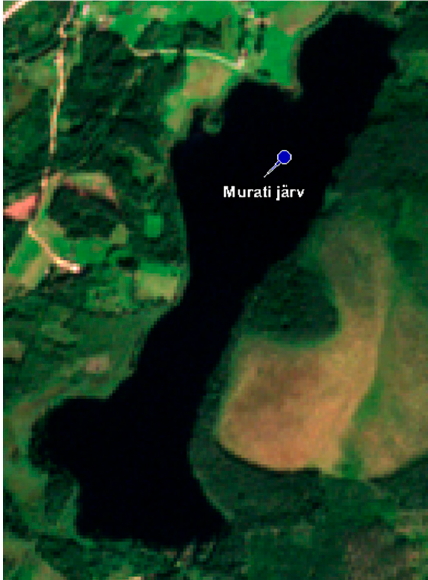
Figure A5. S2 MSI image of Murati from 30th of August 2017.